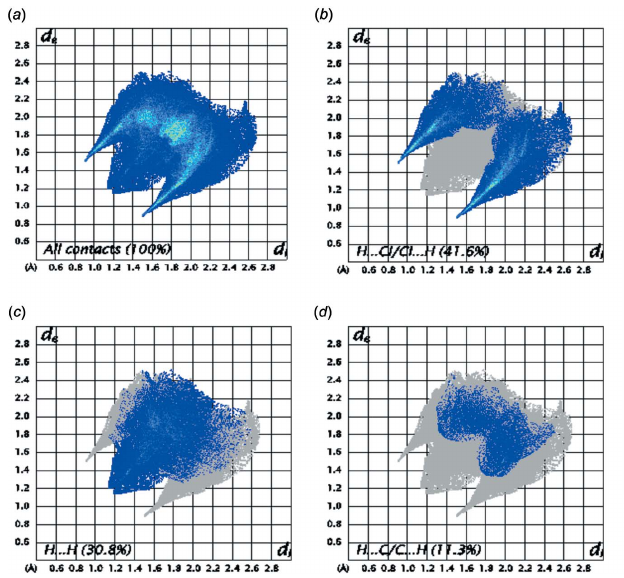
Figure 8 The two-dimensional fingerprint plots of (I), ( a ) showing all interactions and delineated into H (cid:2)(cid:2)(cid:2) Cl/Cl (cid:2)(cid:2)(cid:2) H ( b ), H (cid:2)(cid:2)(cid:2) H ( c ) and C (cid:2)(cid:2)(cid:2) H/H (cid:2)(cid:2)(cid:2) C ( d ) interactions.